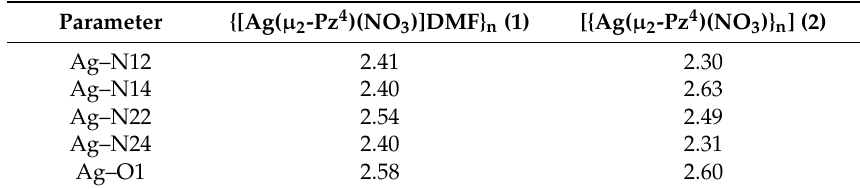
Table 5. Torsion angles of ligand in copper(II) and silver(I) complexes with Pz 4 ligand.